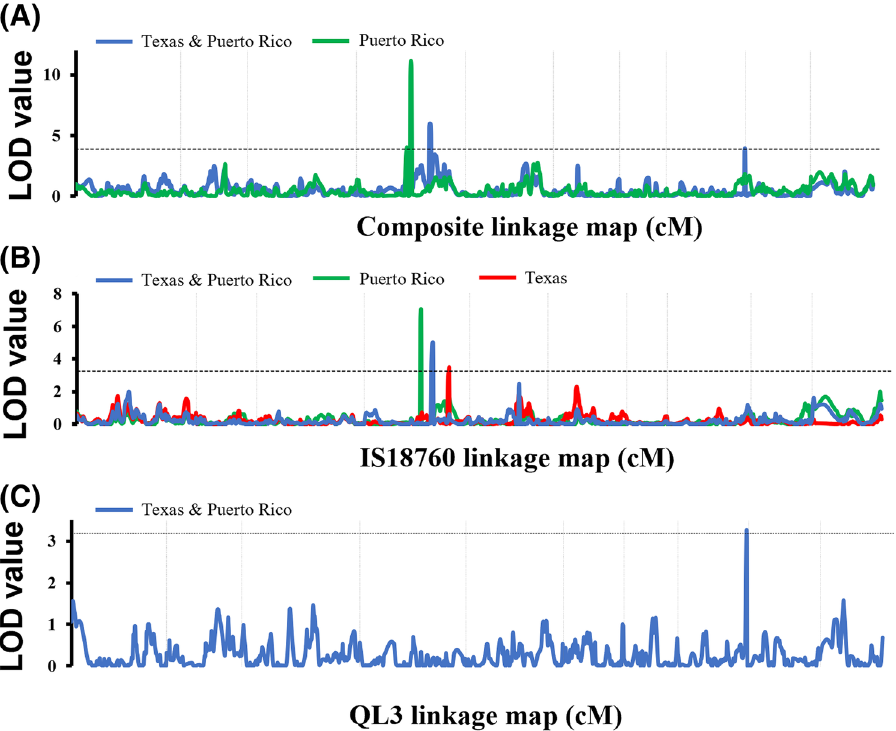
Figure 1. Genome scan for anthracnose resistance response of recombinant inbred lines (RILs) derived from the crosses between IS18760 and QL3 with the common parental line PI609251. ( A ) Joint inclusive composite interval mapping (JICIM) using a composite linkage map and the anthracnose resistance response observed in Puerto Rico and across Texas and Puerto Rico. ( B ) JICIM using the linkage map derived from IS18760 RIL population and anthracnose resistance response observed in Puerto Rico, Texas and across both locations. ( C ) JICIM using the linkage map derived from QL3 RIL populations and anthracnose resistance response observed across Texas and Puerto Rico. Horizontal dashed lines mark the significance threshold ( P < 0.05), and vertical dashed lines delimit the